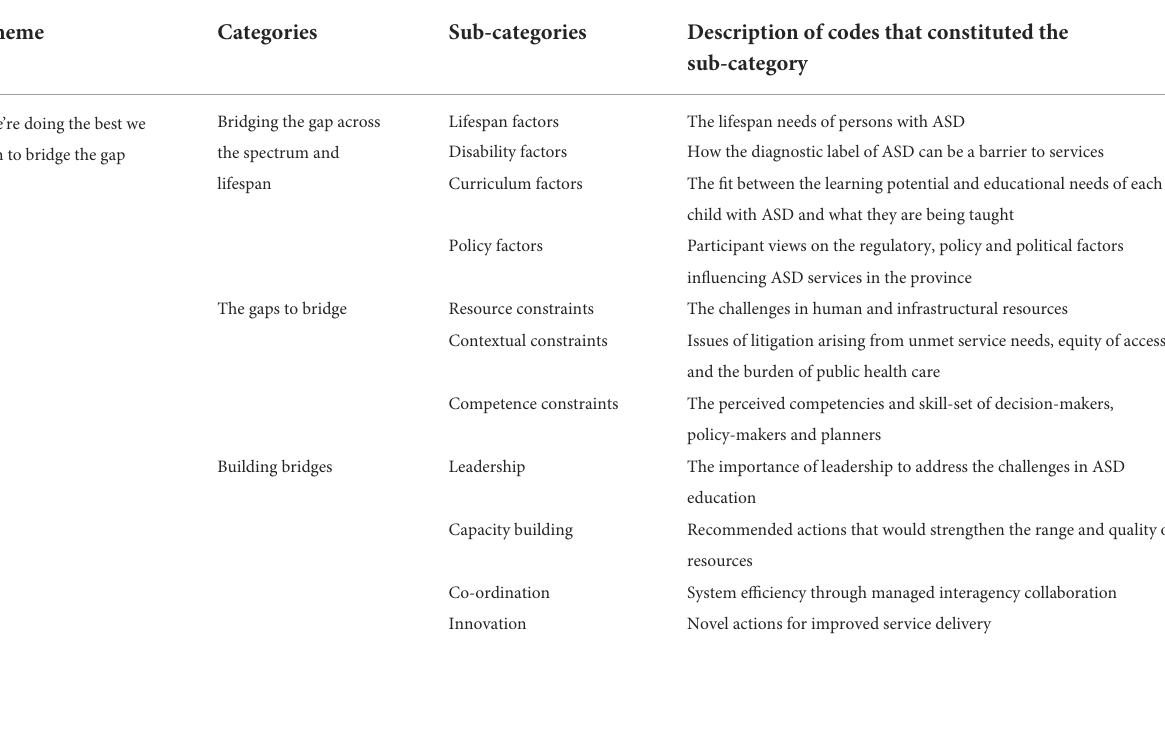
TABLE 2 Summary of main theme, categories and